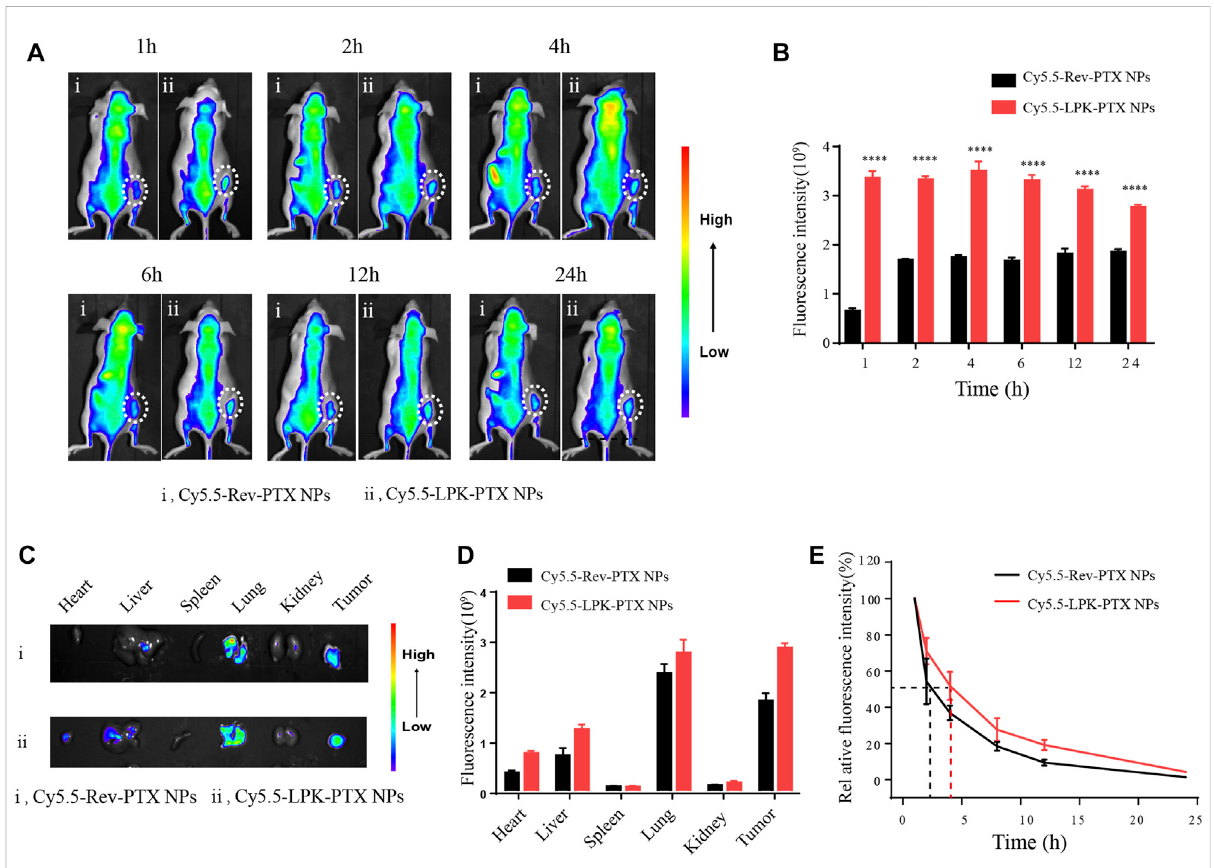
FIGURE 5 In vivo targeted tumor imaging of Cy5.5-LPK-PTX NPs. (A) The whole animal imaging of HCT116 tumor-bearing mice at 1, 2, 4, 6, 12, and 24 h afterintravenouslyinjectionof200 μ lCy5.5-Rev-PTXNPsorCy5.5-LPK-PTXNPs(20 μ g/ml).Thecirclesindicatethelocationsoftumorsinmice. (B) The fl uorescenceintensitiesoftumortissueswerequanti fi ed.**** p < 0.0001. (C) Exvivo imagingofthetumorsandothermajor organs(Heart,Liver, Spleen, Lung, Kidneys) from mice treated intravenously with Cy5.5-Rev-PTX NPs or Cy5.5-LPK-PTX NPs at 24 h. (D) The fl uorescence intensities at the tumor sites and major organs were quanti fi ed. (E) The blood fl uorescence intensity was detected at several time points post-